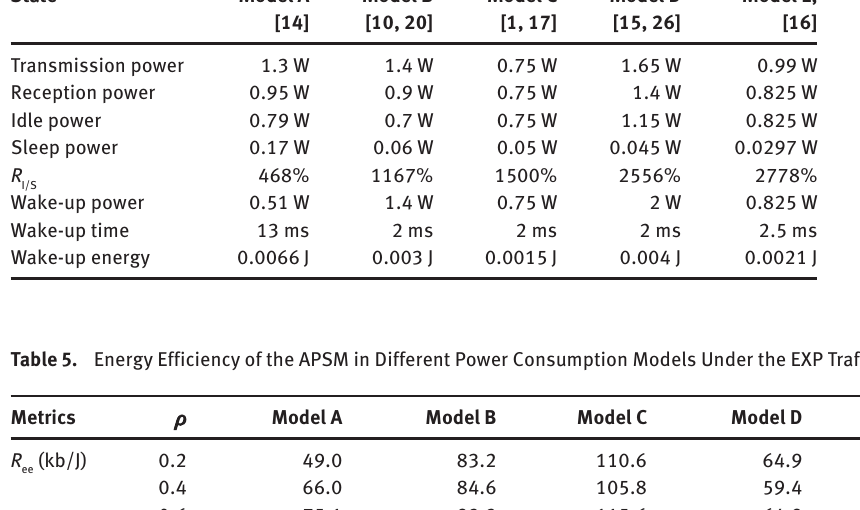
Table 4. Five Power Consumption Models.